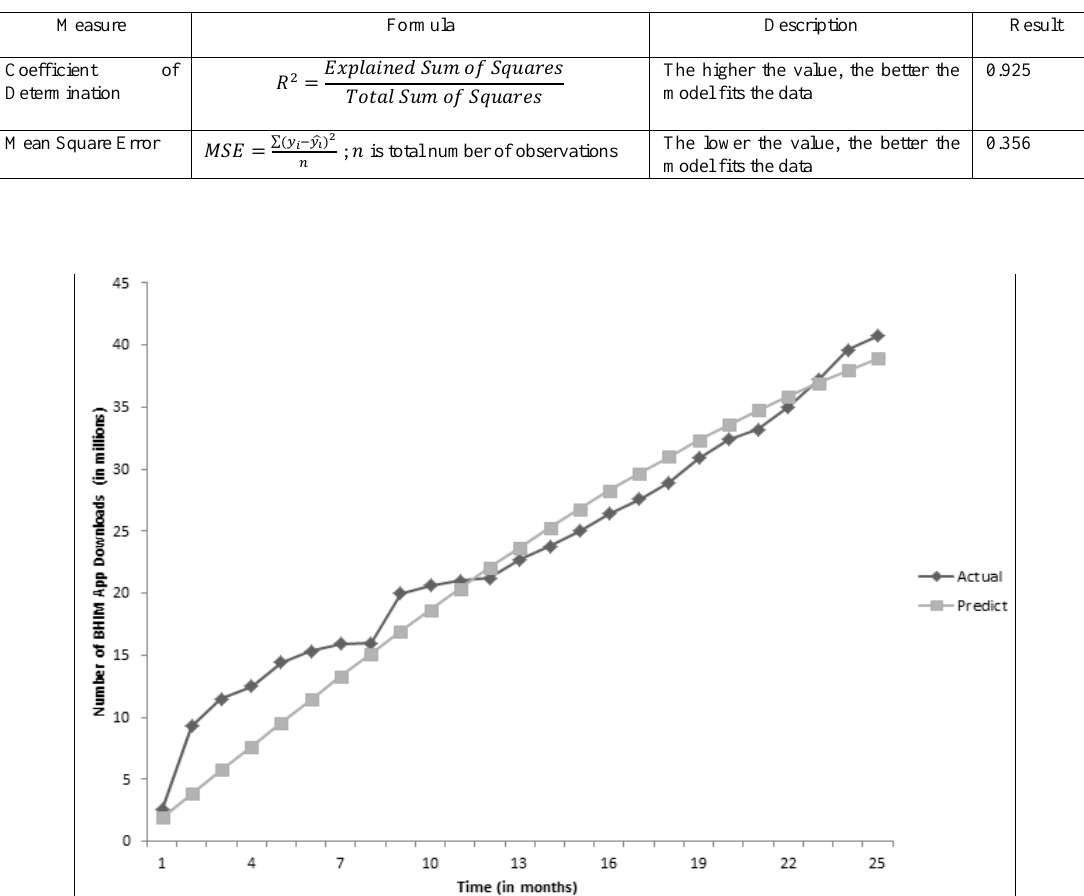
Table 2. Goodness of fit results